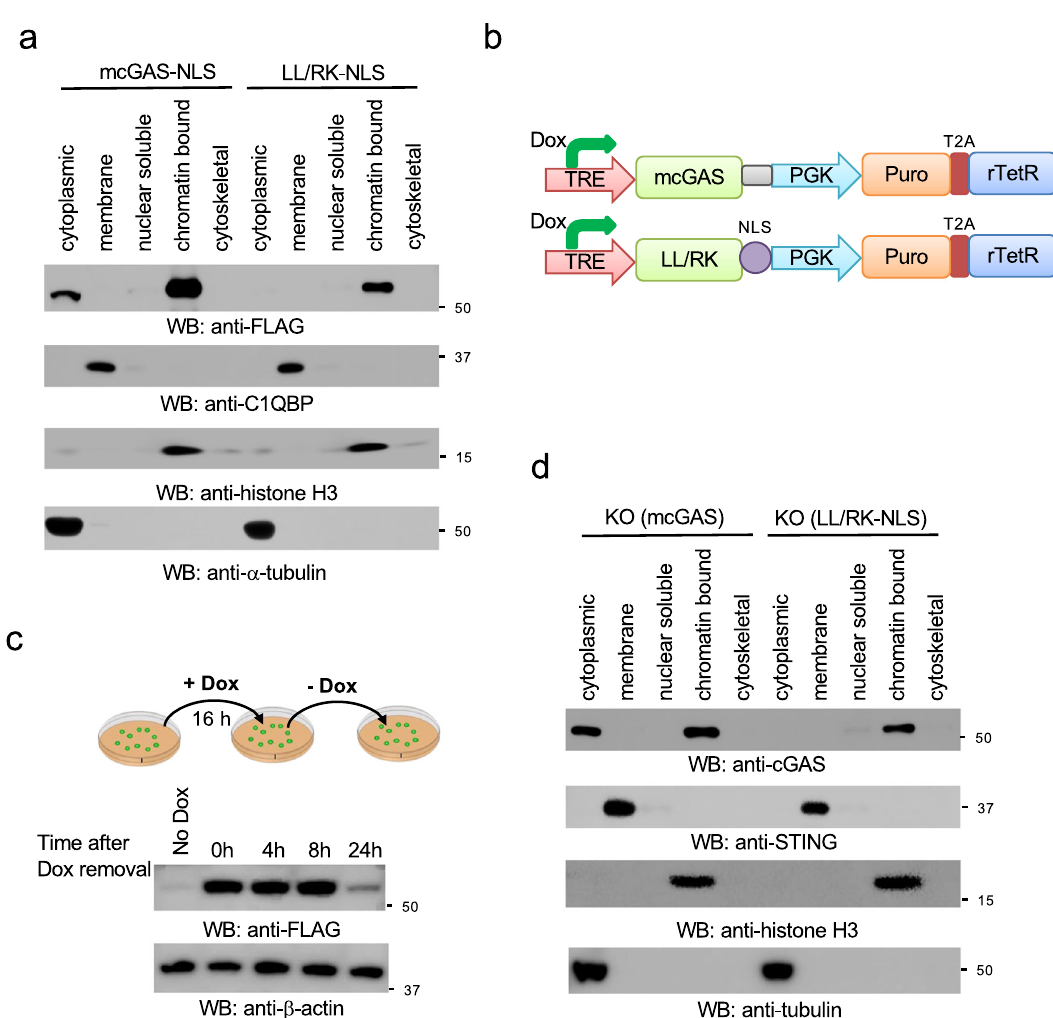
Fig. 4 Generation of a stable cell line exclusively expressing nuclear cGAS. a HEK293 cells stably expressing mouse cGAS fused with a C-terminal NLS (mcGAS-NLS) or the LL/RK-NLS mutant were fractionated and blotted as indicated. C1QBP: membrane marker; α -tubulin: cytosolic marker; H3: nuclear marker. b Schematic of the doxycycline (Dox)-induced mcGAS and LL/RK-NLS constructs. TRE: Tet Response Element; Puro: puromycin; T2A: Thosea asigna virus 2A-like peptide. c HEK293 cells stably expressing mcGAS were treated with 2 μ g/mL Dox for 24 h. Cells were harvested at the indicated times after Dox removal. Cell lysates were blotted as indicated. d Stable cGAS knockout RAW264.7 cells reconstituted with the inducible mcGAS or the LL/RK- NLS mutant were treated with 2 μ g/mL Dox for 24 h. Then cells were fractionated into fi ve fractions and blotted as indicated. STING: membrane marker; α